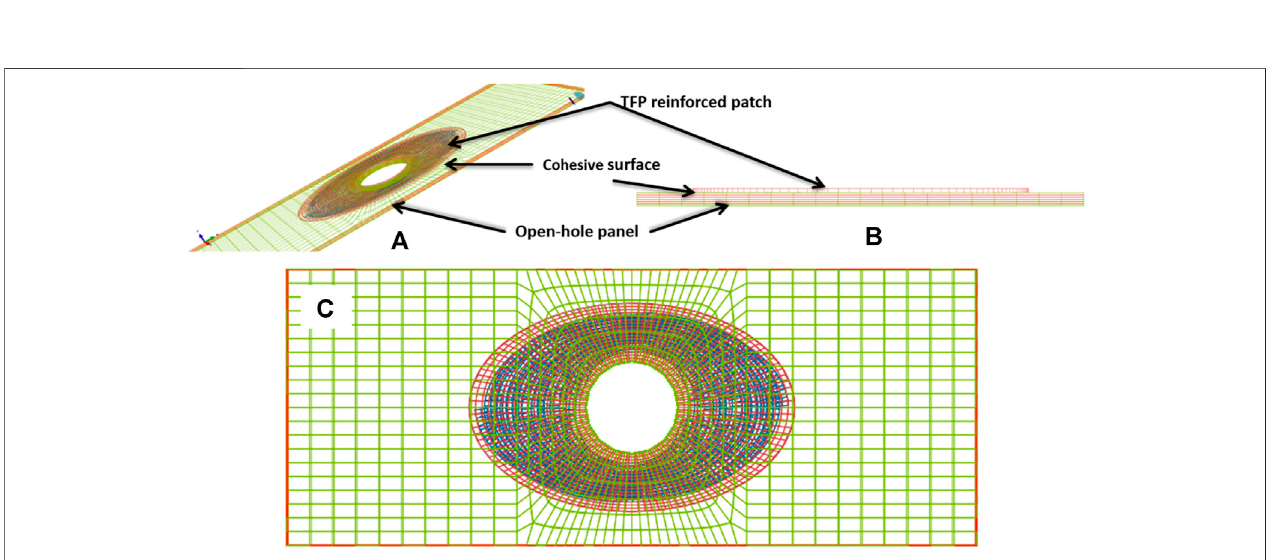
FIGURE6| ThewholesetofTFP-reinforcedcouponswheretheTFPpatchandpliesareassembledtogetherusingtheSBCBM: (A) ISOviewofthemodel, (B) side view of the model, and (C) top view.